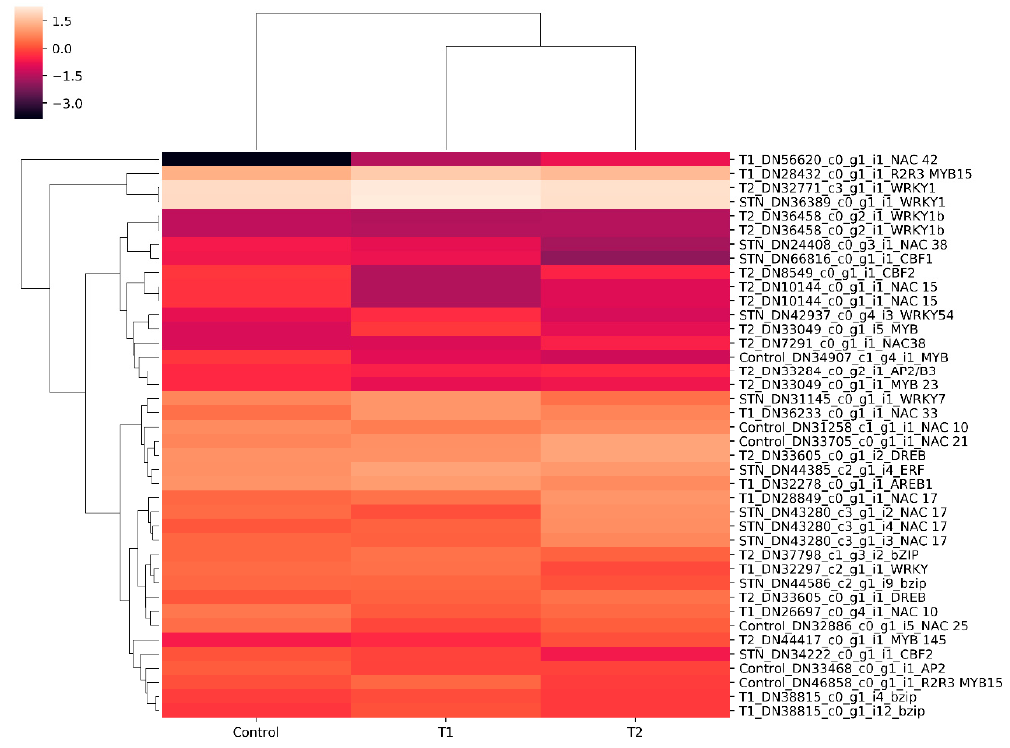
Figure 10. Differential gene expression patterns of transcription factors (TFs). Heat map showing differential expression of different TFs in the control, T1 (48 h PEG treatment), and T2 (72 h PEG treatment) samples.